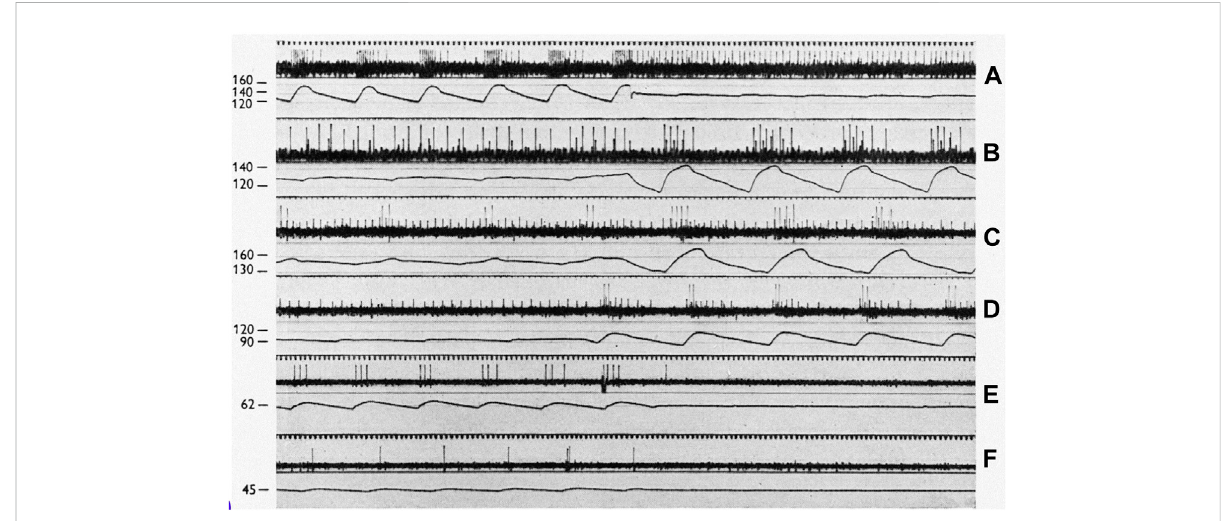
FIGURE 12 Ona50cycles/sectimescale,eachpaneldisplayssinusbaroreceptorunitactivityinresponsetosinuspressure(SP)labeledinmmHgtotheleft. (A) :effectoftransitionfrompulsatiletonon-pulsatilesinusblood fl owatSPof140 mmHg(catl). (B) :transitionfromnon-pulsatiletopulsatilestateat SP of 130 mm Hg (cat 2). (C,D) (cat 3) transitions at 150 and 95 mmHg, respectively. Please note that the small action potentials are from a SBR and the large ones from a RBR unit. (E,F) (cat 4) transitions at 62 and 45 mmHg, respectively. [Figure 1 (Ead et al., 1952)].